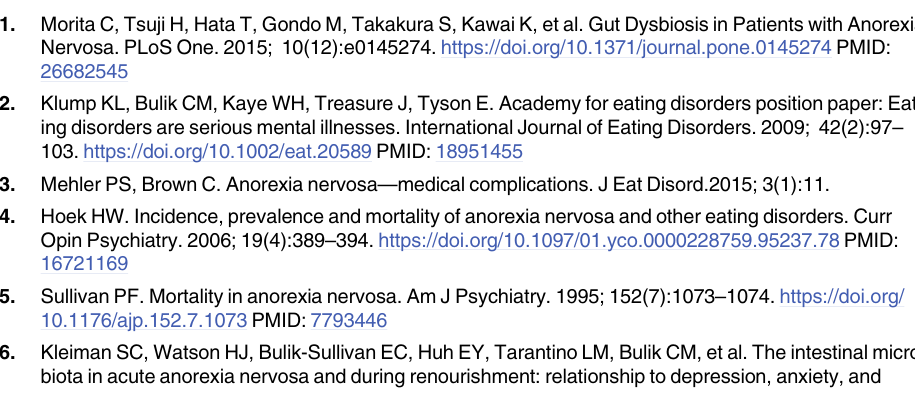
S1 Table. Cohort description (demographic, anthropometric, biochemical, and psycholog- ical data), diet and short-chain fatty acids concentrations. S1 Fig. Relative abundance of most represented microbial genera. Bar charts showing the relative abundance of the most represented genera, defined as having a mean relative abun- dance of > 1%, in stool samples of anorexia nervosa (AN, n = 15) and control (CTR, n = 15)